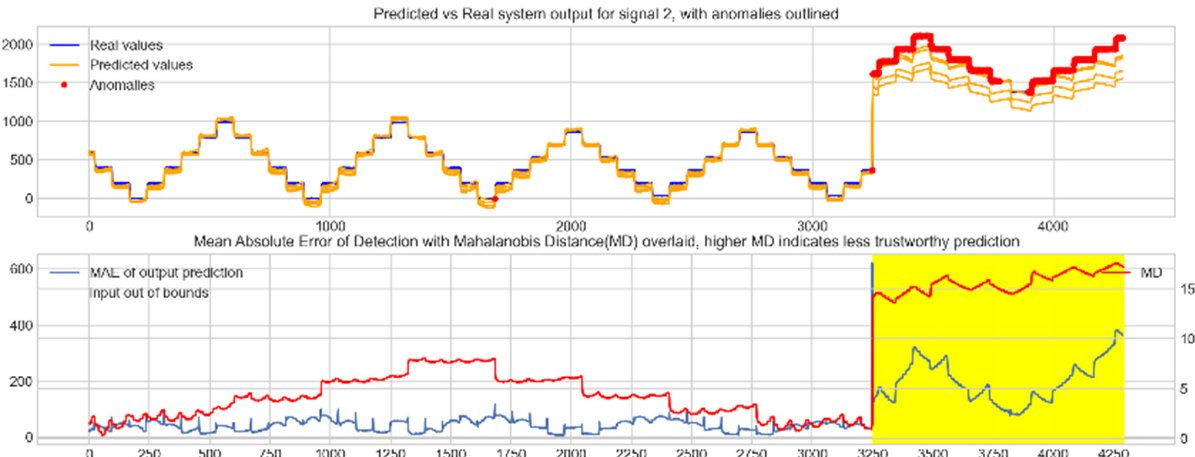
Figure 17. Bias fault inserted in input signal 1, the right elevon, from data point 3250 onwards, with NN anomaly detection highlighted in red and inputs outside the expected input space shaded in yellow.